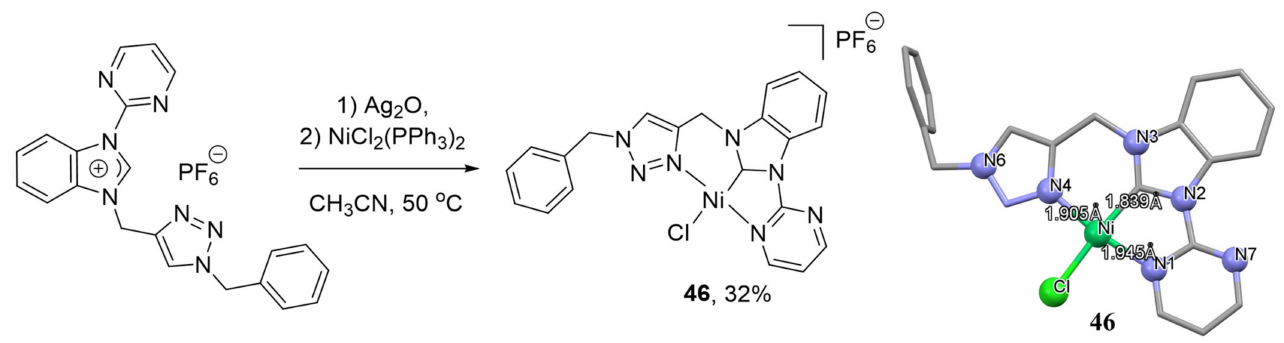
Scheme 25. Synthesis of unsymmetrical NHC pincer nickel complex 46 [140]. The electrochemical generation of NHC containing unsymmetrical pincer nickel com- plex 47 has been described by some of us (Scheme 26) [141,142]. It was found that cathodic reduction of the imidazolium salt (LHBr in Scheme 26) in the presence of nickel (II) ions leads to the formation of N -heterocyclic carbene complexes of nickel (II) with the molecular hydrogen as the only byproduct. Interestingly, the imidazolium salt plays a role of both NHC source and electrolyte, while the source of nickel ions is the nickel plate.